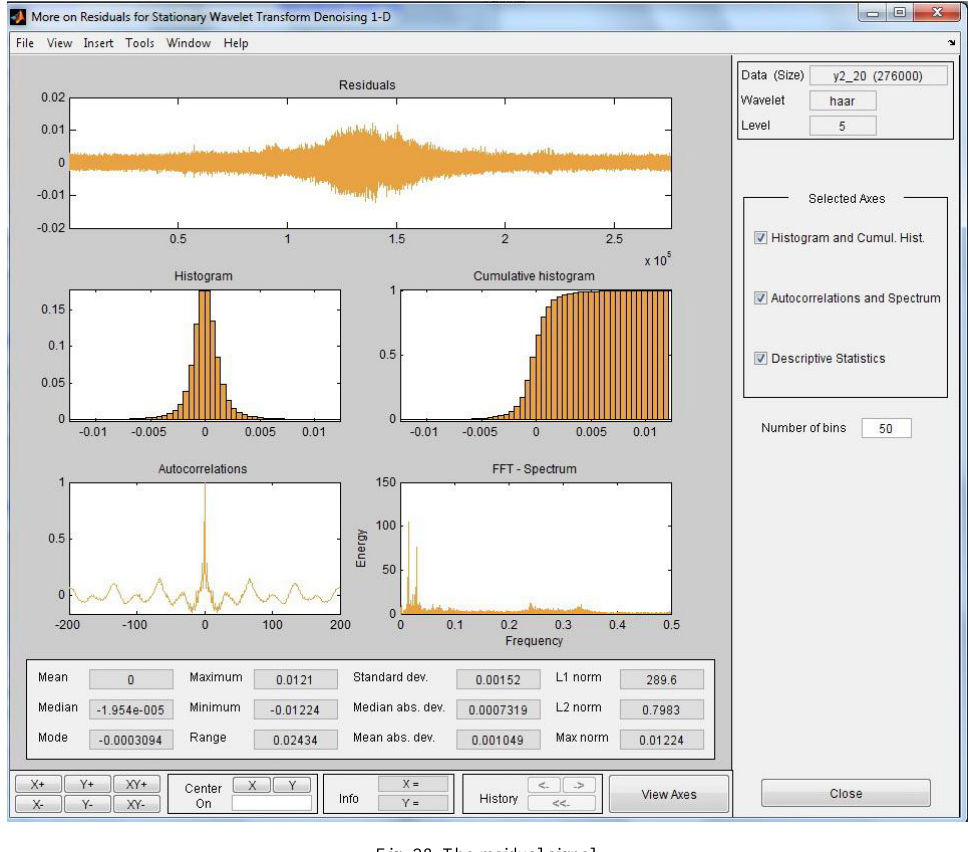
Fig. 28. The residual signal.